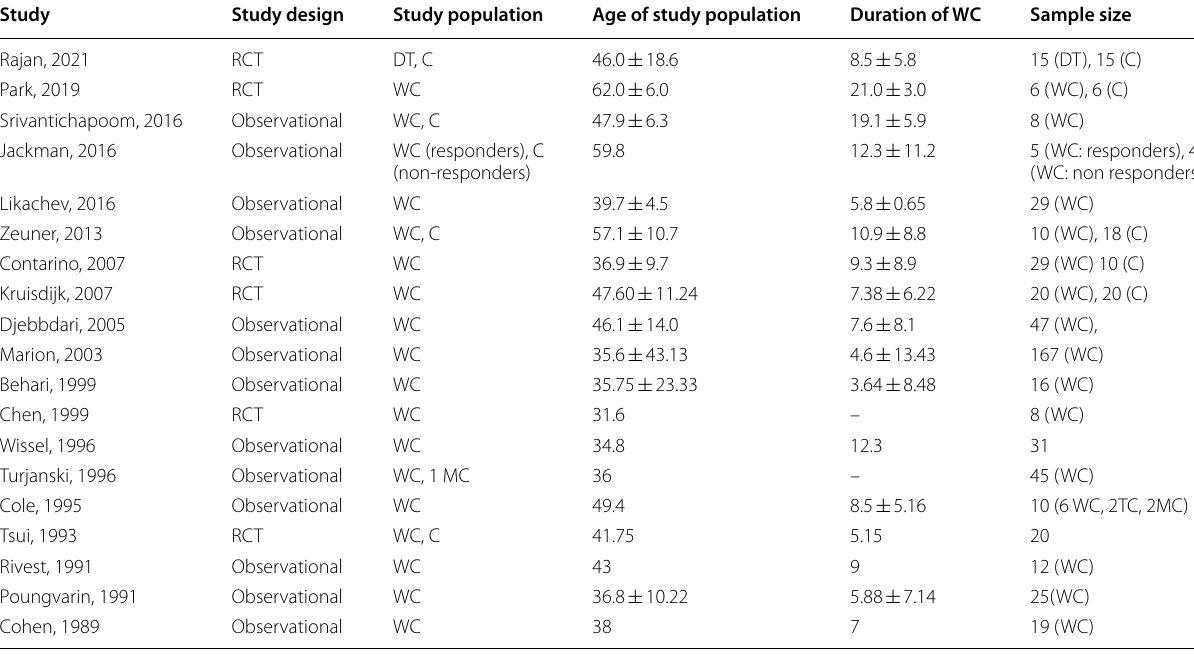
Table 1 Characteristics of included